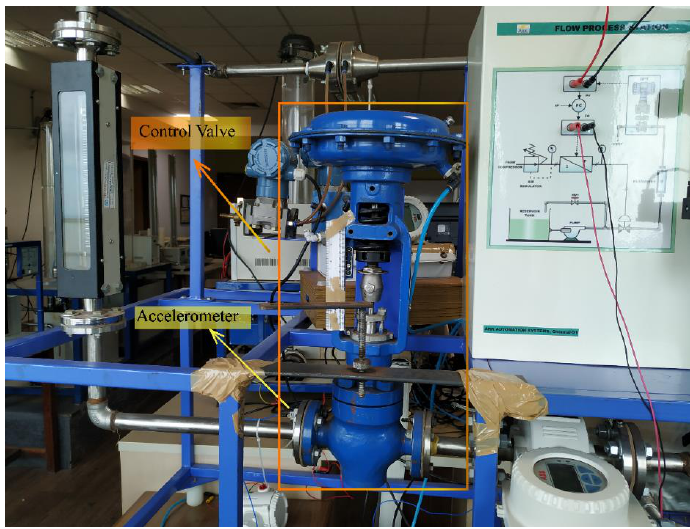
Figure 2. Flow process setup .